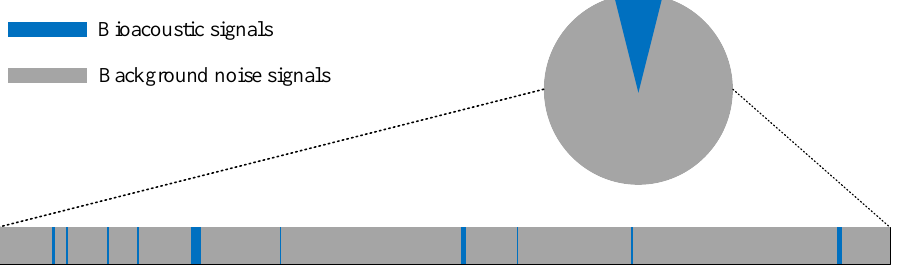
Figure 1. Diagrammatic sketch of distribution and proportion of bioacoustic signals and background noise signals in aquaculture.